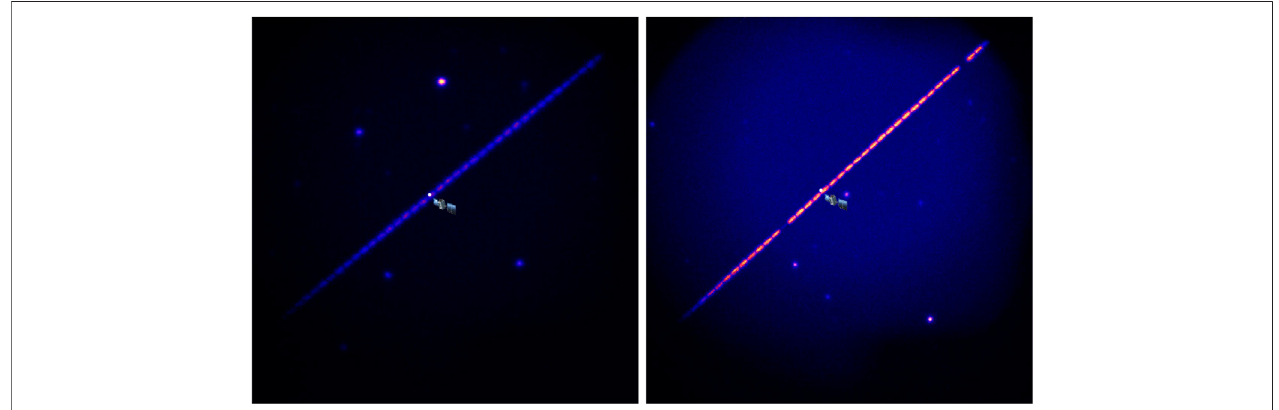
FIGURE 11 | These are stacks of frames from a larger series taken from Gemini-North with ‘ Alopeke on June 14th, 2020. The target is a crowded fi eld that coincides with the path of the satellite GPS BIIR-2 PRN 13 aka “ G13 ” . G13 crossed the wide fi eld of the instrument moving at a rate of 35.4 ″ /sec. A series of 60 ms exposures were taken in wide-fov mode. The images shown are from the 716 nm fi lter. The known position for observation time 14:49 UTC based on the ephemerides for the satellite is shown and corresponds to frame number 132 in the sequence left . The satellite path corresponds to frame 331 for the 14:55 UTC series right . Each “ dash ” in the stacked image corresponds to one exposure. Note that twoof thedashes appear fainter in the 14:55UTC stack due toimage scaling but this has no impact on the measurement. Based on the timestamps recorded for the frames and the known time for the position of the GPS satellite we can conclude the absolute time accuracy for the instrument is ∼ 160 ms. For relative time measurements/kinetic cycle time within a fi le sequence the time precision is 70